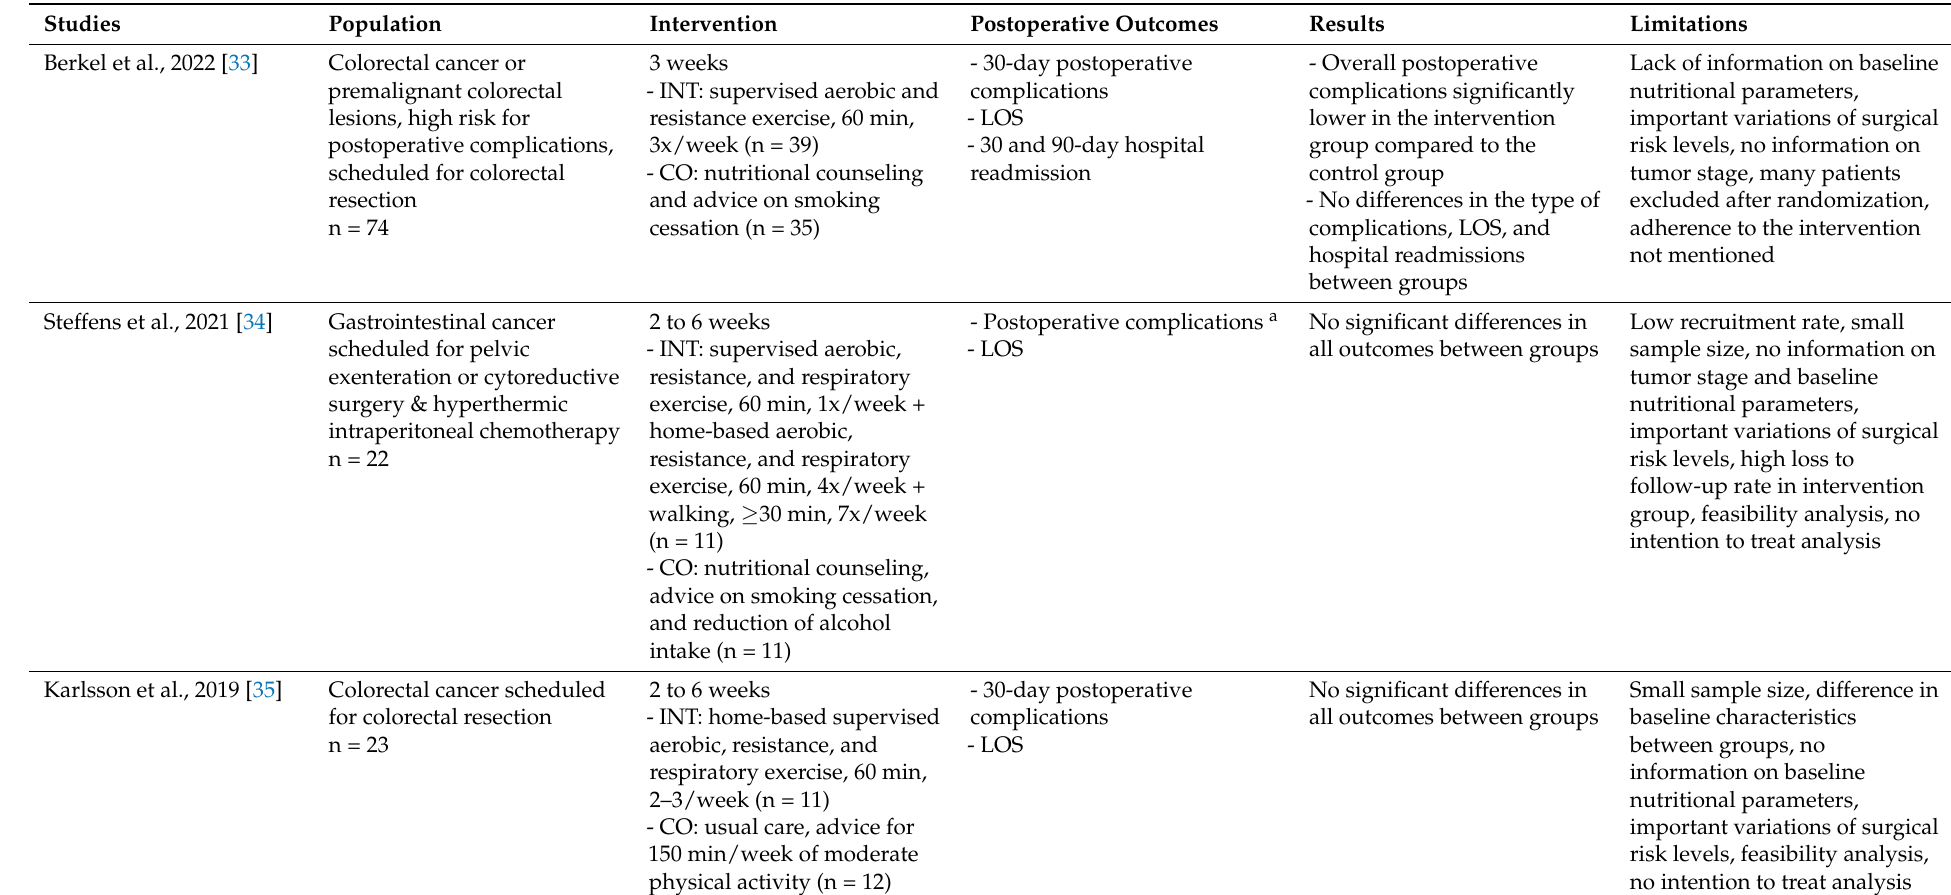
Table 2. Physical activity interventions before surgery in patients with gastrointestinal